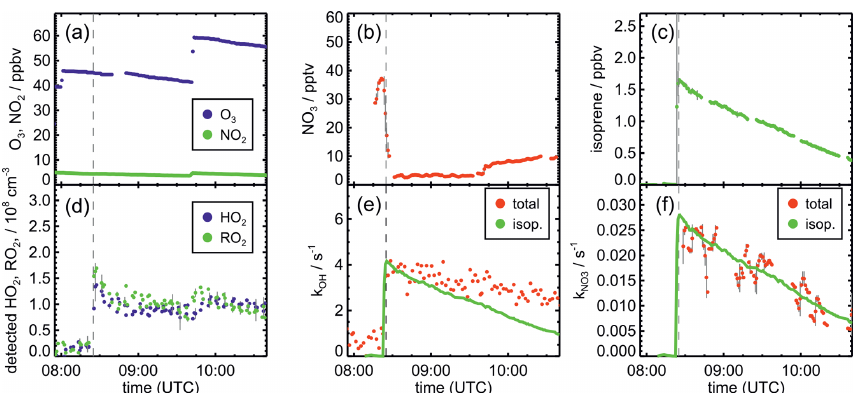
Figure A1. Measurements of radical and trace gas concentrations and OH and NO 3 reactivity in the experiment on 10 August 2018 (Exper- iment 2) investigating the oxidation of isoprene by NO 3 . NO 3 reactivity does not include reactivity from organic radicals and NO 2 . OH and NO 3 reactivity from isoprene is calculated from measured isoprene concentrations and reaction rate constants recommended in the literature (Mellouki et al., 2021). Observed RO 2 radicals only include a fraction of the total RO 2 because the LIF instrument cannot detect all RO 2 radicals formed in the reaction of isoprene with NO 3 (Vereecken et al., 2021).